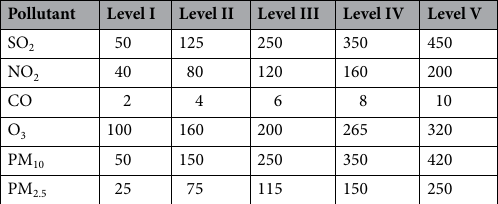
Table 2. Air quality standards.